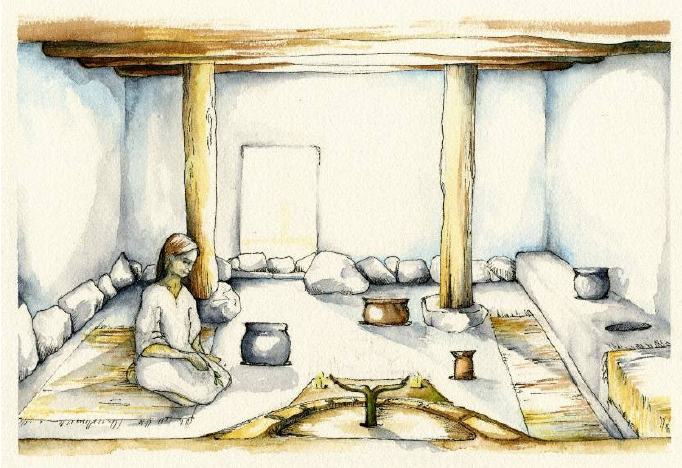
Figure 12. Artistic reconstruction of interior of Non-Domestic Building (drawing by Laurel D. Hackley).